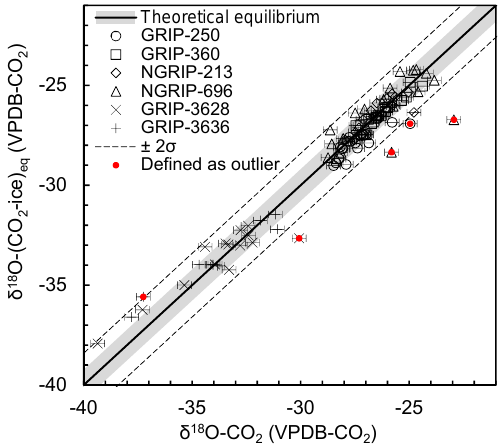
Figure 8. δ 18 O-CO 2 used as a quality control tool for ice core measurements. The correlation between measured ( x axis) and ex- pected ( y axis) δ 18 O-CO 2 is shown for samples from GRIP and NGRIP measured in high spatial and temporal resolution for sec- tions with gas ages of 260 to 1770 years and 25000 years. The expected δ 18 O-CO 2 was derived considering thermodynamic equi- librium of gaseous CO 2 with the surrounding ice matrix and is ac- cordingly denoted as δ 18 O-(CO 2 -ice) eq . The calculated theoretical equilibrium (black line) is shown with an uncertainty band (grey), accounting for the error associated with equilibrium temperature es- timates. The dashed line indicates the 2 σ standard deviation around the theoretical value considering all data points shown. For sam- ples outside this range (red dots) CO 2 and δ 13 C-CO 2 results were